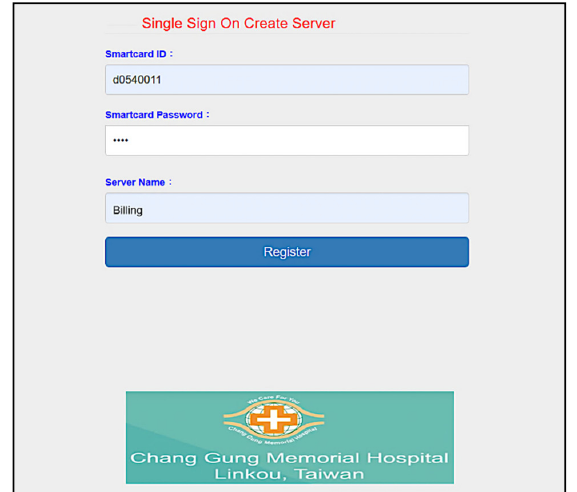
Figure 10. Server creation.